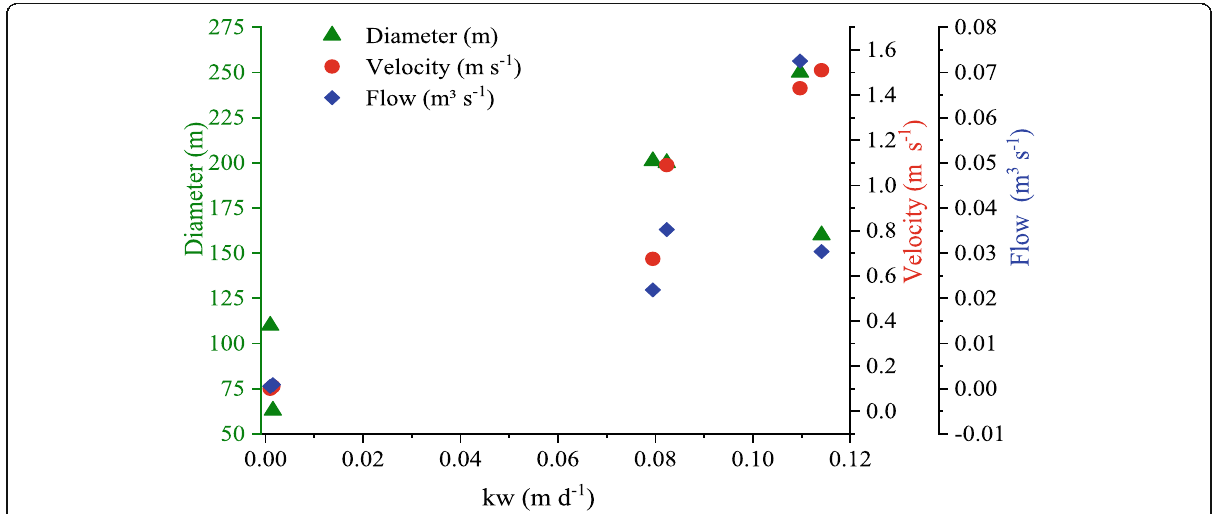
Fig. 4 Variation of kw as a function of the pipe diameter, speed and water flow. In the figure, it can be seen that kw maintains a direct relationship with velocity, but not with diameter and